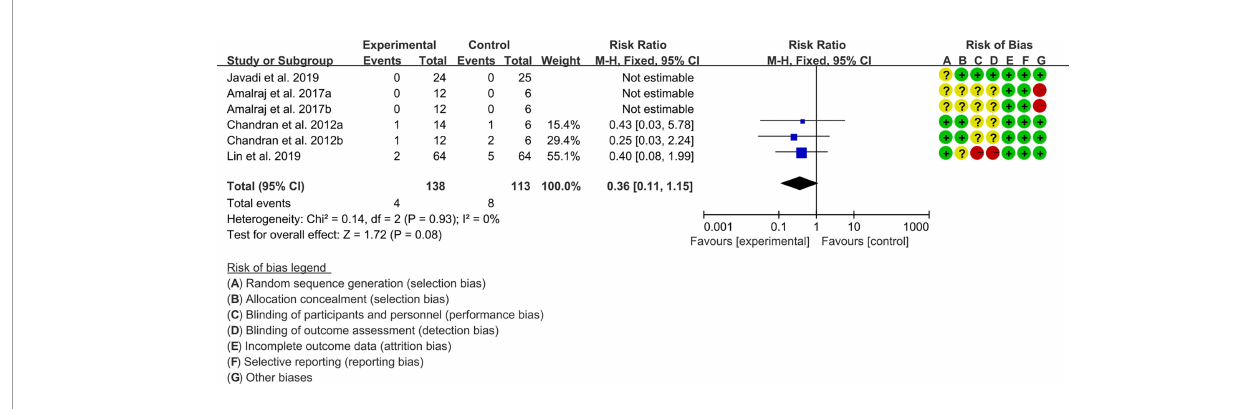
FIGURE 6 | Adverse events.